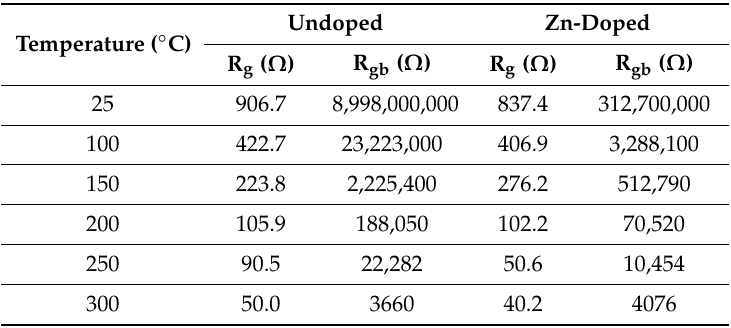
Table 1. Grain and grain boundary resistance for undoped and Zn-doped calcium copper titanate (CCTO) at temperature range of 25–300 ◦ C.